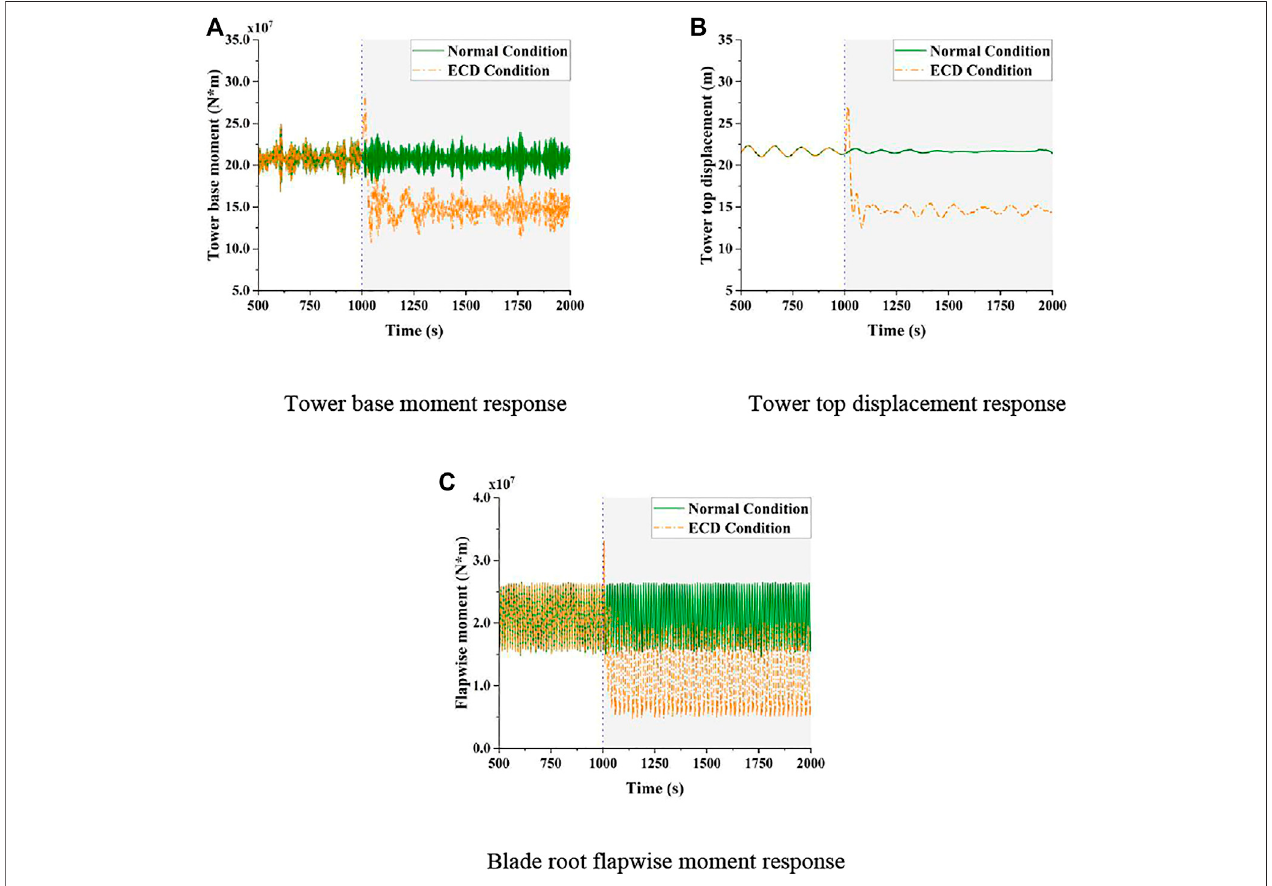
FIGURE 15 | Structural dynamic response of the 15 MW FOWT under the normal condition and ECD condition. (A) Tower base moment response. (B) Tower top displacement response. (C) Blade root fl apwise moment response.